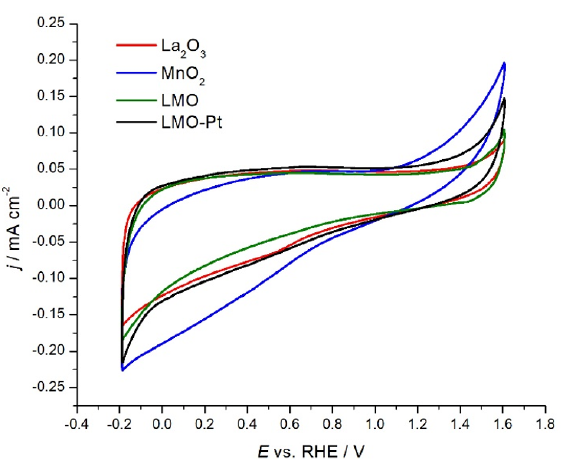
Figure 1. Stable cyclic voltammograms of La 2 O 3 , MnO 2 , LMO, and LMO-Pt thin-layer electrodes at scan rate of 50 mV s − 1 in N 2 -saturated 0.10 M KOH at room temperature.